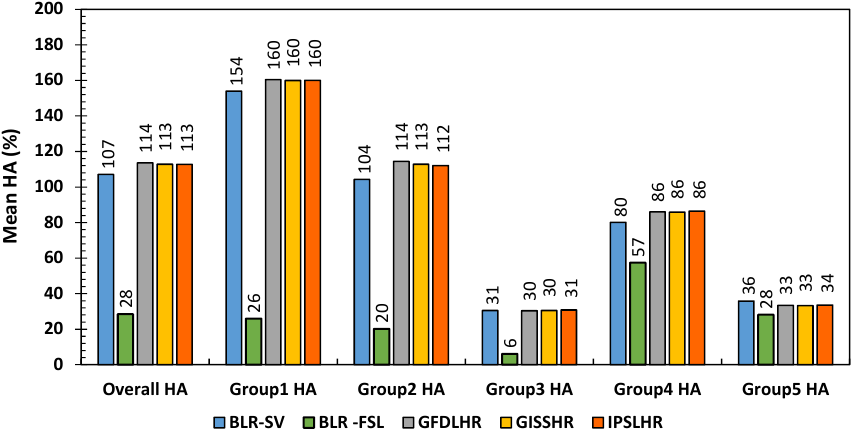
Figure 10. Comparison between mean HA of the baseline climate using the seasonal variation rule curve (BLR-SV scenario) and the full supply rule curve (BLR-FSL scenario), for GFDL, GISS and IPSL models under high emissions scenarios using the seasonal variation rule (denoted as GFDLHR, GISSHR and IPSLHR) for overall HA and the five HA groups considered.